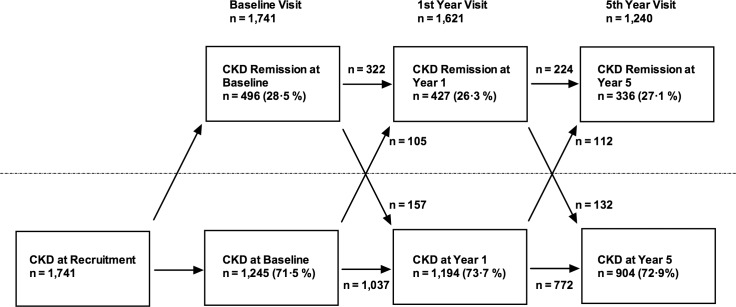
Flowchart showing numbers of participants demonstrating CKD and CKD remission at each study visit.Arrows indicate numbers of participants transitioning from one condition to the other.